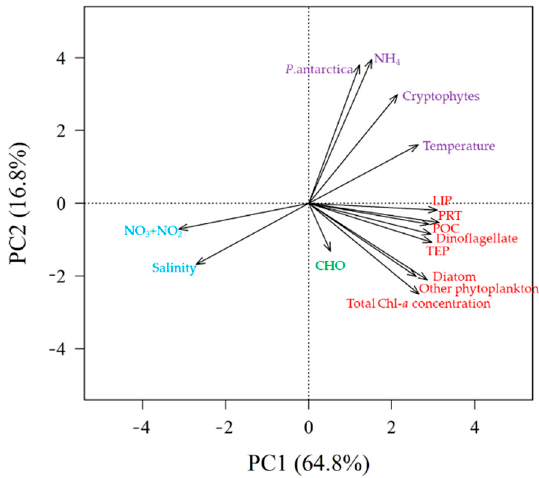
Figure 11. Principal component analysis based on environmental factors and biochemical